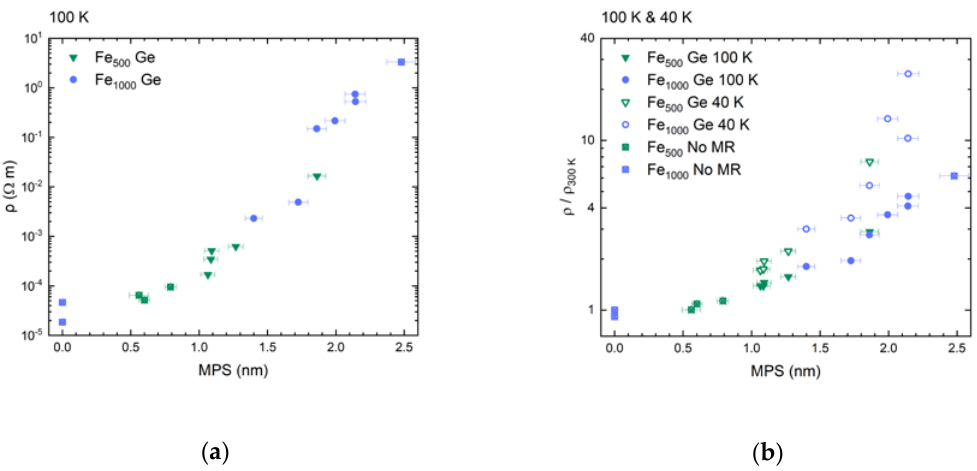
Figure 15. ( a ) Resistivity at 100 K and ( b ) relative resistivity at 100 K and 40 K vs. mean particle separation MPS . Both physical quantities exhibit an exponential dependence on MPS . Crossed symbols represent samples not showing magnetoresistive behavior at 100